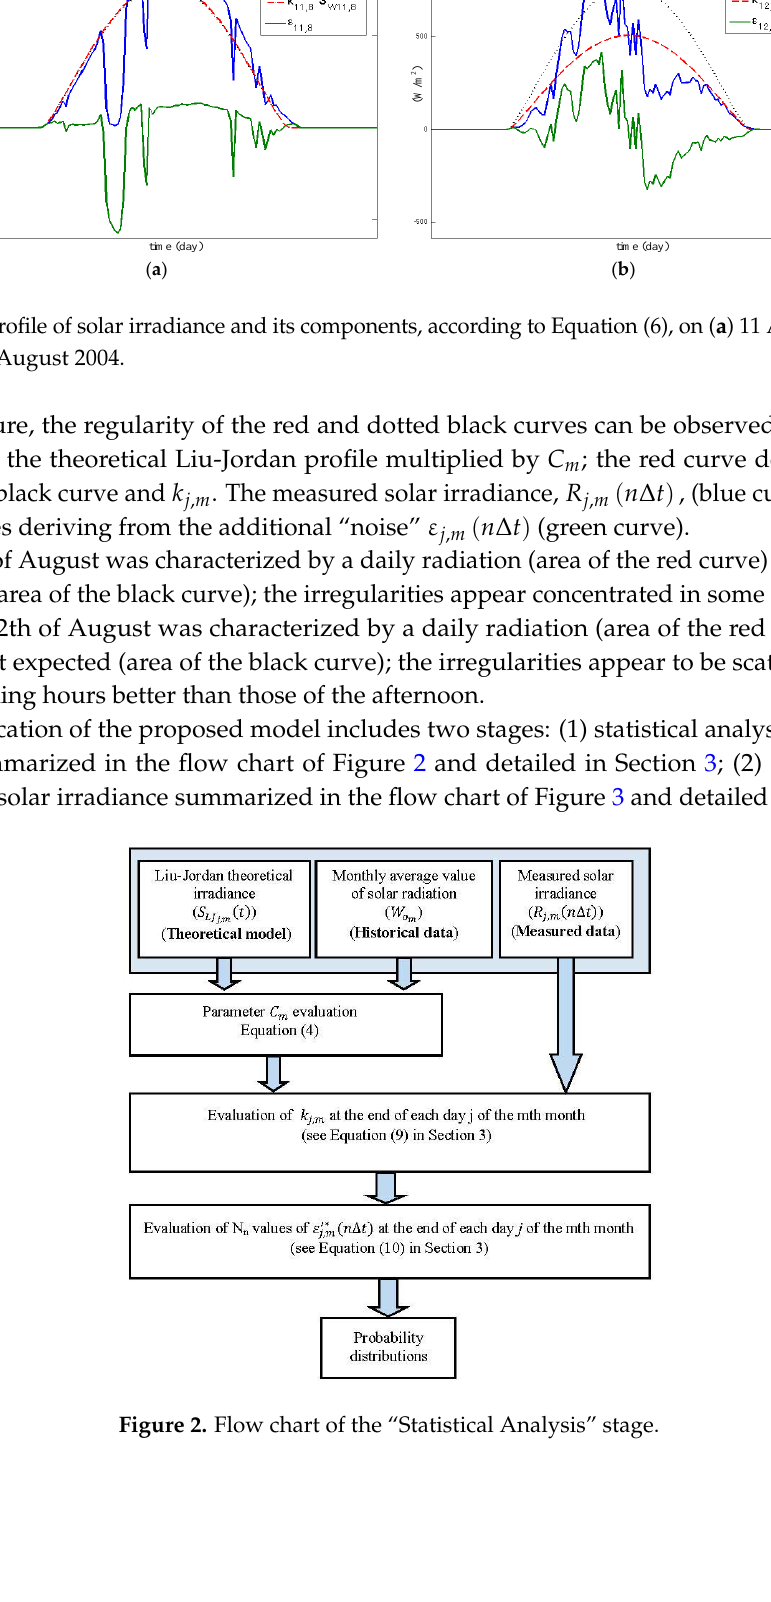
Figure 2. Flow chart of the “Statistical Analysis” stage.